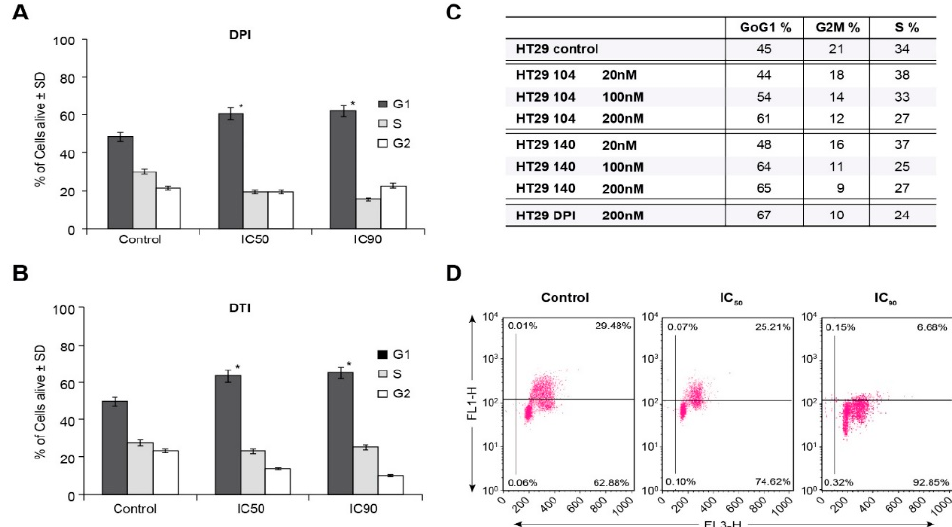
Figure 4. HT-29 G1/S cell cycle block produced by iodonium analogs. DPI and DTI inhibit cell cycle progression into S phase at their IC 50 and IC 90 concentrations ( A , B ). NSC 751140 and NSC 740104 also produce a G1/S cell cycle block in HT-29 cells at nM concentrations ( C ). Measurement of S-phase progression using BrdU incorporation confirms the decrease in S-phase cells produced by DPI in HT-29 cells. The FL1 channel represents BrdU incorporation, and the FL3 channel used 7-amino-actinomycin D as a measure of DNA, both expressed in arbitrary units ( D ). *, p < 0.005. Results are representative of three